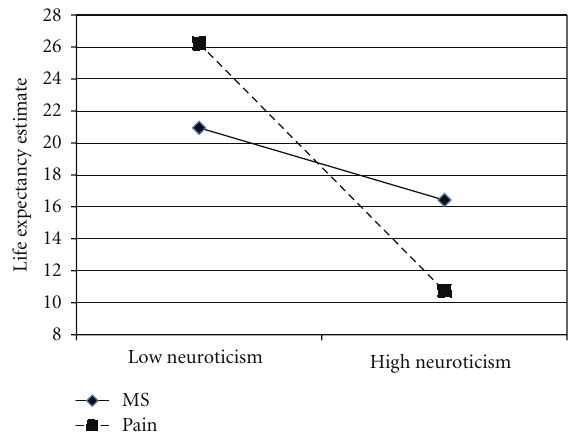
Figure 2: Life expectancy estimates as a function of mortality salience and neuroticism among young-old adults. Note that scores indicate estimated remaining years to